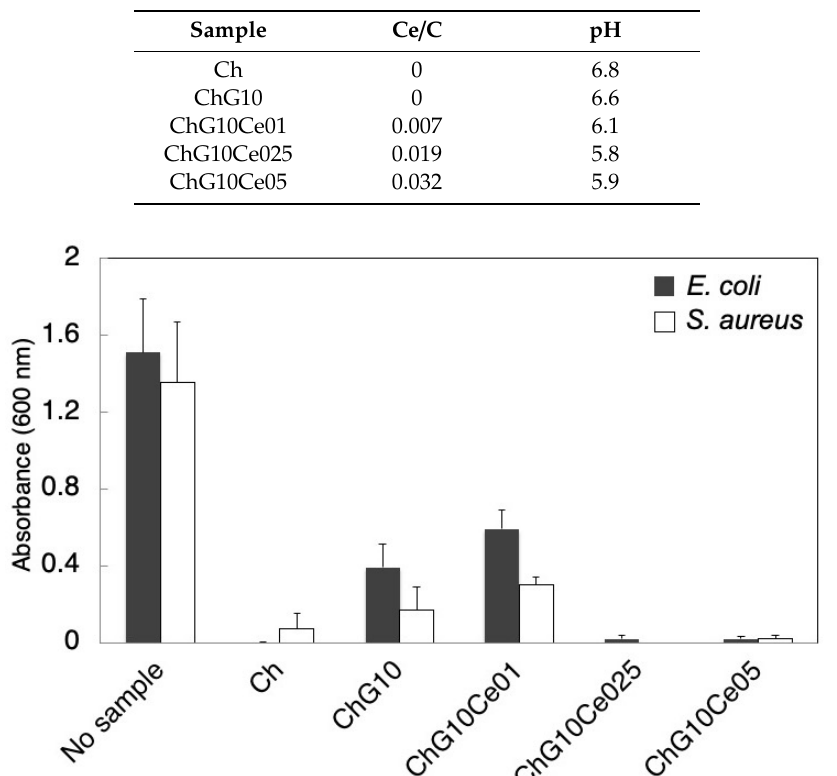
Table 3. Cerium / carbon atomic ratios on spheres surfaces obtained using EDX and pH values of PBS after soaking spheres for 24 h.